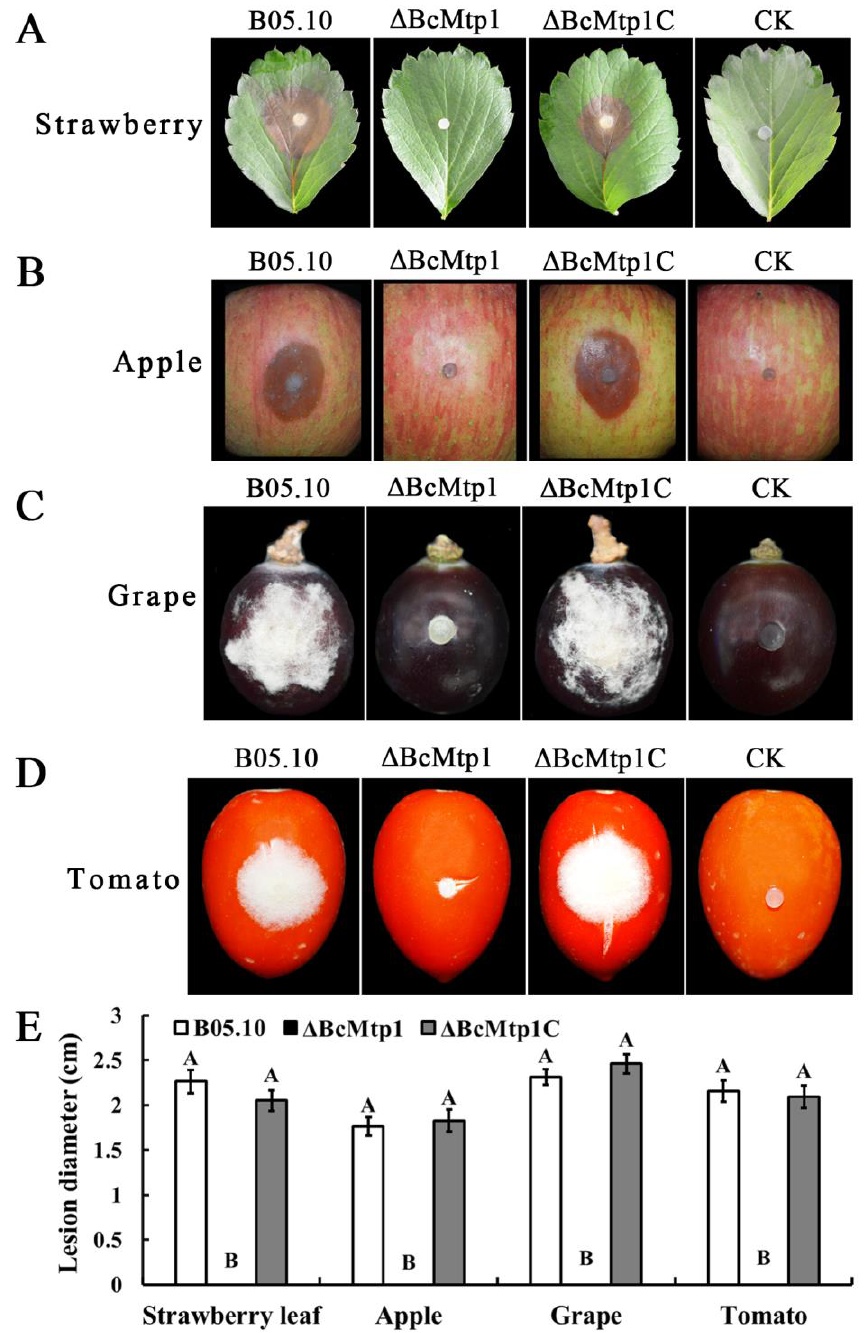
Figure 6. Pathogenicity analysis on various plant tissue, following inoculation with the parental strain B05.10, ∆ BcMtp1 , and ∆ BcMtp1C . Agar plugs were used as negative controls (CK). ( A ) Disease symptoms on wounded strawberry leaves after 80 h post inoculation (h.p.i.), ( B ) wounded apple fruits 80 (h.p.i), ( C ) wounded grape fruits 72 (h.p.i), ( D ) wounded tomato fruits 72 (h.p.i), and ( E ) Diameter of disease lesion on various plant tissue. Bars denote the standard deviation of four repeated experiments. Values on the bars followed by the same letter are not significantly different at p = 0.05.